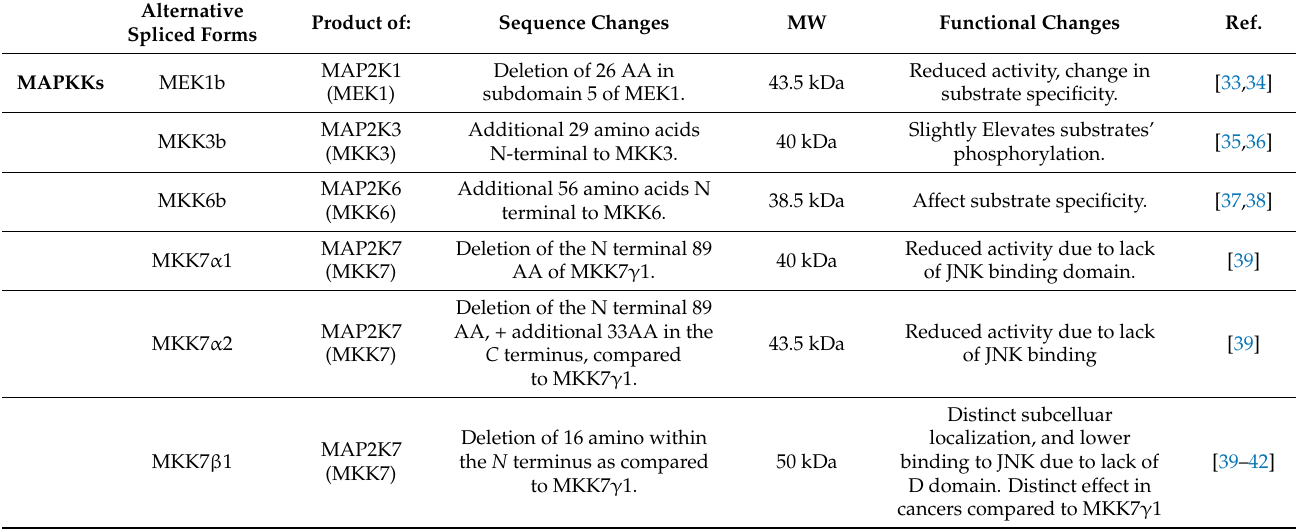
Table 1. Characteristics of the alternative spliced isoforms of the components of the MAPKKs and MAPKs of all four MAPK cascades. The alternatively spliced isoforms presented are only from proteins whose expression has been confirmed, although more lowly expressed forms whose transcripts have been identified may exist. The structural and functional properties of the lowly expressed alternatively spliced isoforms of the ERK1/2, p38, and ERK5 cascades are presented as compared to the main isoforms. These main isoforms are not presented here as their properties are very well covered in many other reviews. As for the components of the MAPKK tier of the JNK and p38 cascade, the alternatively spliced isoforms are presented as compared to the main isoforms MKK3, MKK6, MKK4 and MKK7 γ 1 (not presented), whose expression is usually higher than the others, although the latter might be substantially expressed in some cells. Due to similar expression level of several JNKs, there is no “main” isoform and the comparison of the spliced isoforms is to the other components in the